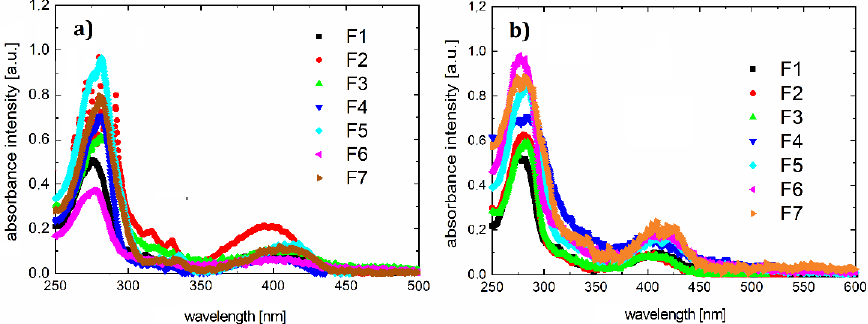
Figure 2. Absorption spectra for F1–F7 samples in chloroform ( a ) and thin film on quartz ( b ).